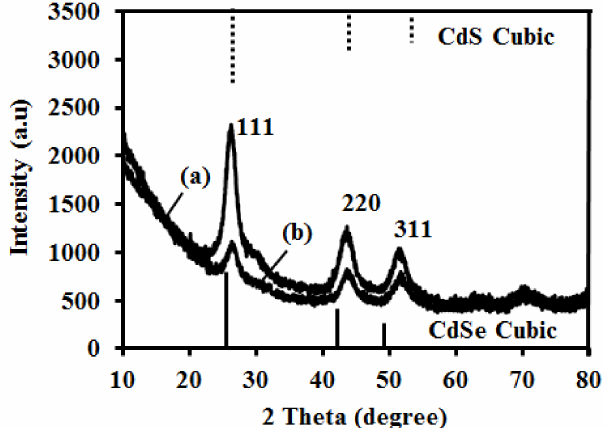
Figure 1. PXRD of as- synthesized QDs: ( a ) CdSe QDs and ( b ) CdSe(S)/ZnO